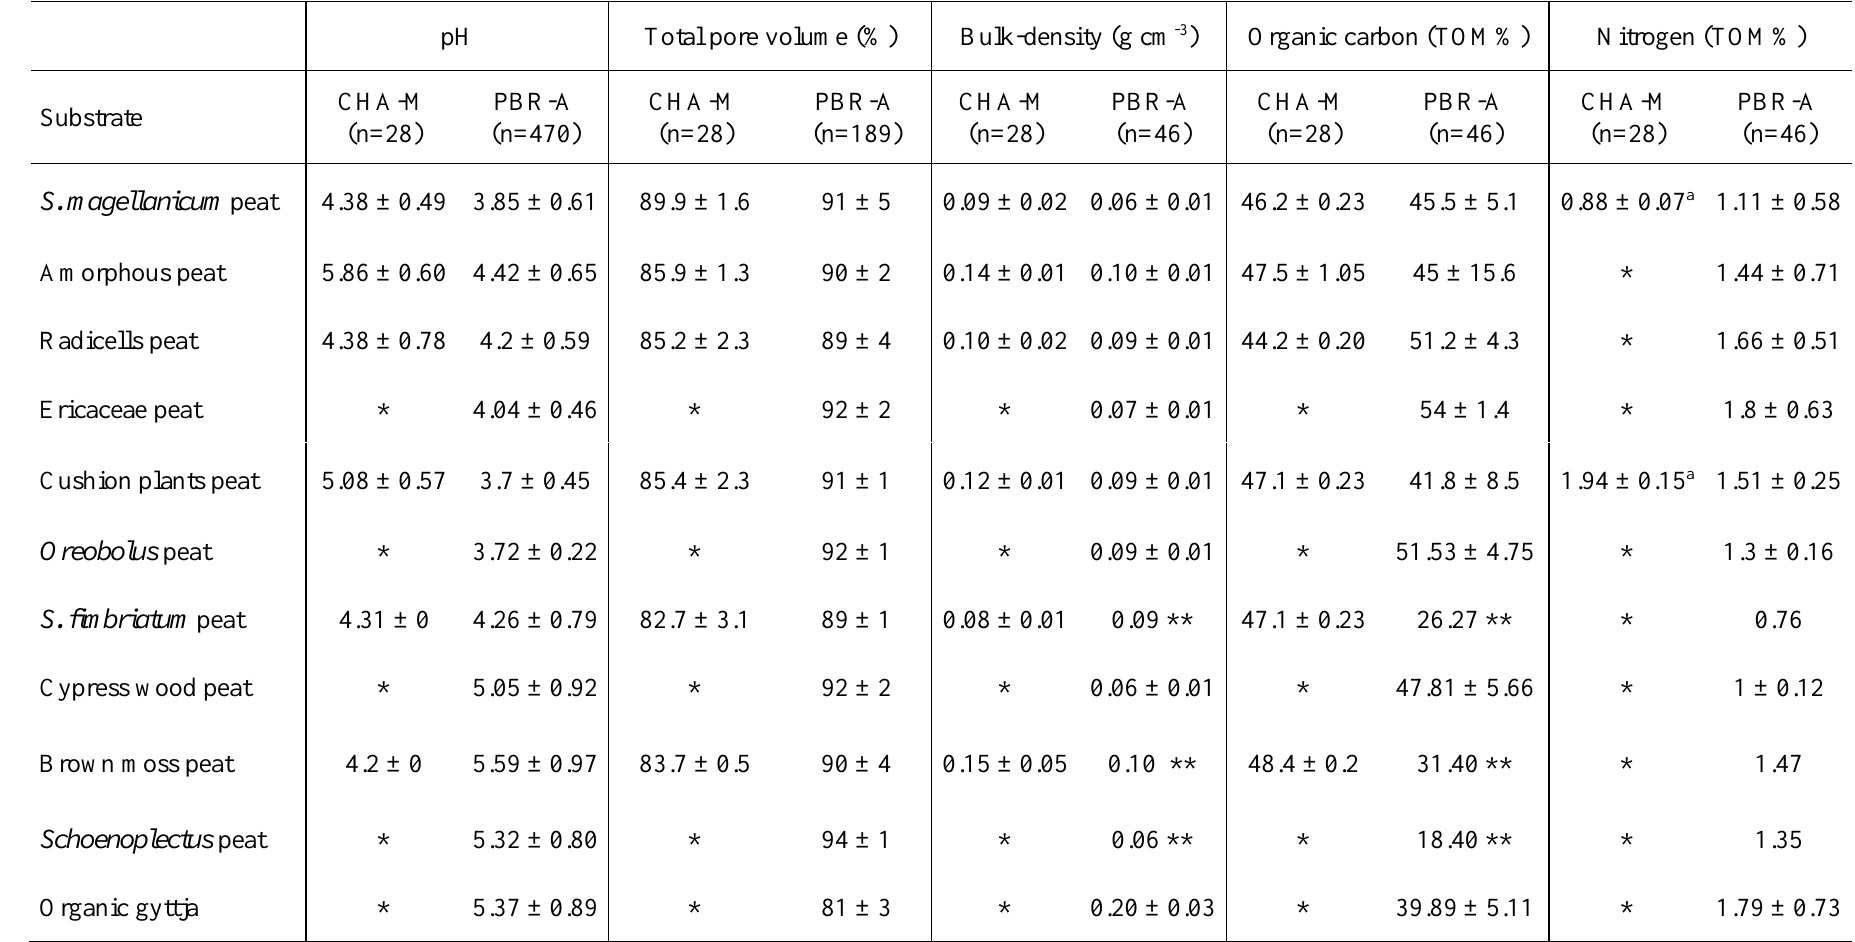
Table A1. Peatland substrate types and values for specific factors in Aysén and Southern Magallanes (Chile) sites. CHA-M = peatlands on islands of the Cape Horn Archipelago - Magallanes. PBR-A = peatlands in the Pascua & Baker Riverbasins - Aysén (Rodríguez unpublished data). a Data from Kleinebecker (2007) for different mires of Magallanes and Tierra del Fuego. *No value available, **No standard deviation